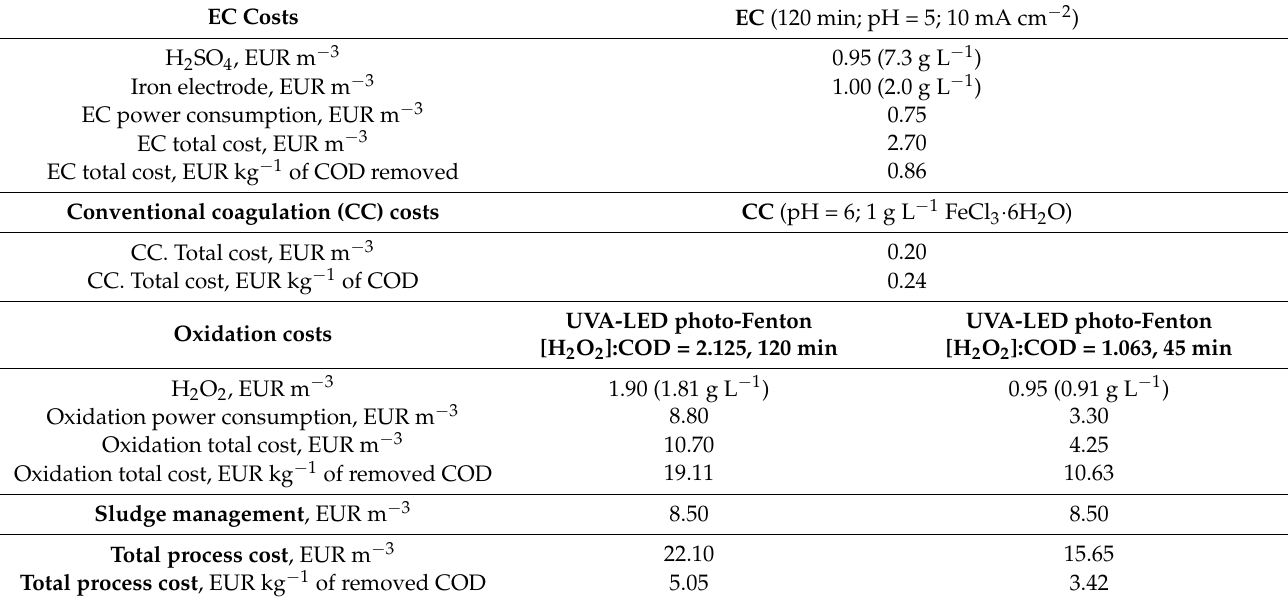
Table 4. Treatment cost assessment of the individual and global processes included in the herein assayed optimized treatment combination strategy for landfill